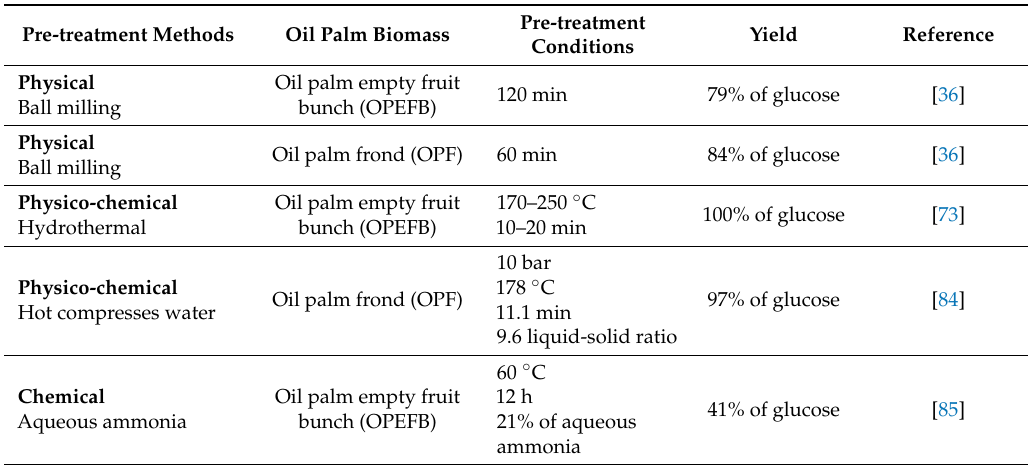
Table 3. Pre-treatment performances on various oil palm